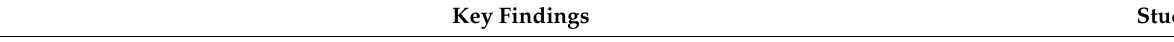
Table 1. Key findings of selected studies conducted on asphalt binders and